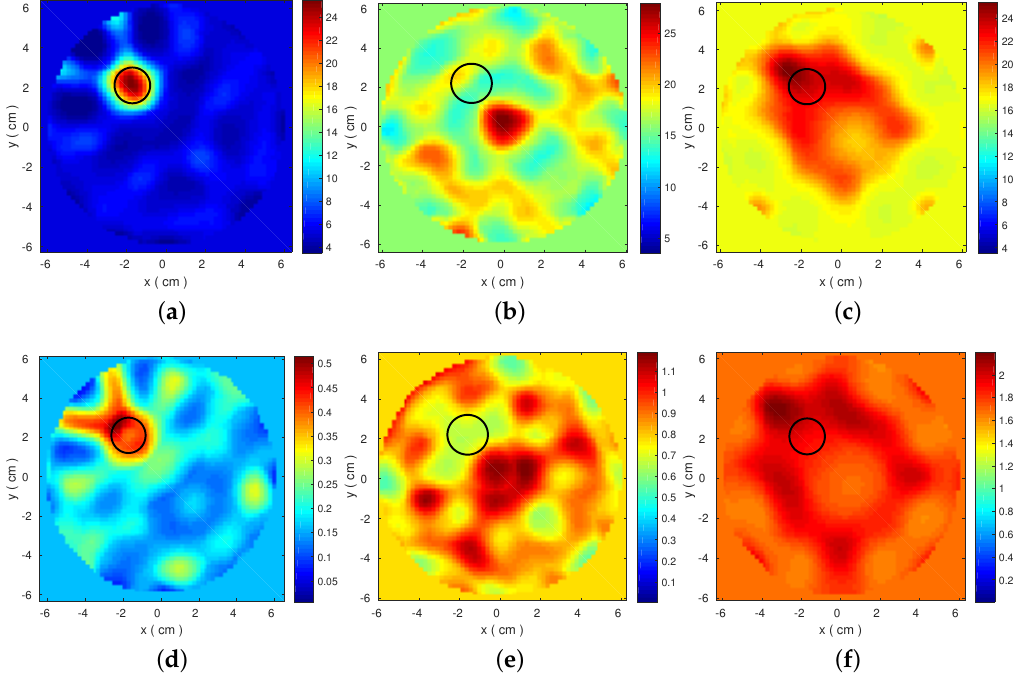
Figure 3. 2-D reconstructed complex permittivity distributions from 3-D CST simulated data for the three different background media considered, using a frequency hopping approach in the range 1.5–2.7 GHz. Top images reconstruct the real part (cid:101) (cid:48) for ( a ) Triton X-100; ( b ) 90% corn syrup; and ( c ) 80% glycerine, and the bottom images correspond to (cid:101) (cid:48)(cid:48) for ( d ) Triton X-100; ( e ) 90% corn syrup; and ( f ) 80%